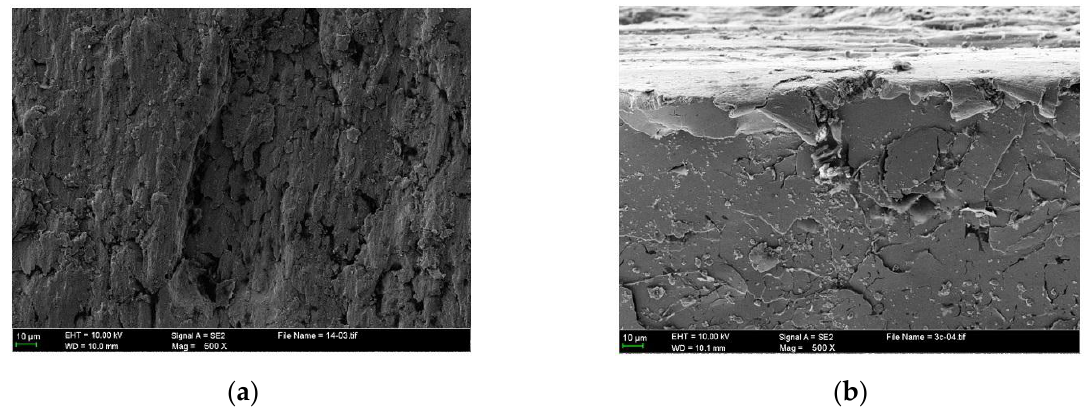
Figure 6. Enlarged worn surface ( a ) and cross section morphology ( b ) of severely damaged region from the scuffed liner of NCM/Fe.